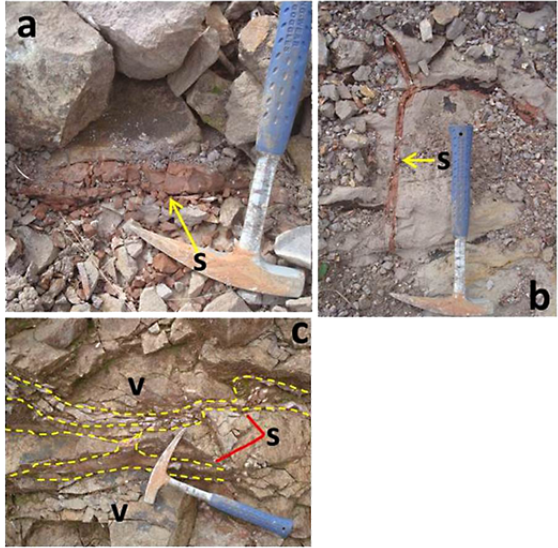
Fig. 6. Blocky jointed peperite in the base of an ATP-type unit (Domingos Soares city – Paraná State, central region of the Paraná Basin): V – ATP rock; S – sediment.